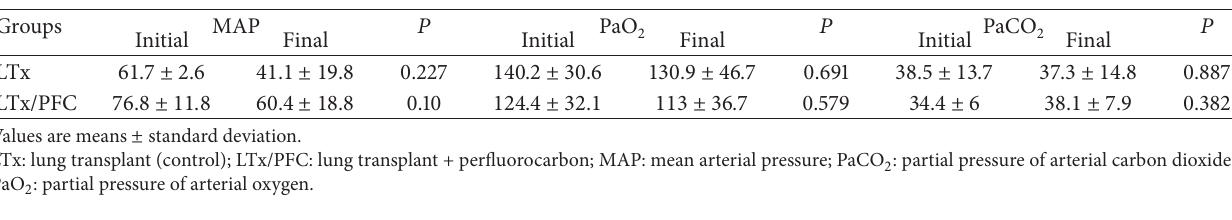
Figure 4: Immunofluorescence staining of caspase 3 (a) and I 𝜅 B (b). Cy3-positive cells (nucleated cells) are in red. There was an increased number of apoptotic cells by caspase 3 staining in the LTx group (A1) and an inhibition of phosphorylation of the inhibitor I 𝜅 B in the LTx/PFC group (B2). ((A1) and (B1)—LTx group; (A2) and (B2)—LTx/PFC group.) Table 1: Hemodynamics and gas exchange in the transplantation